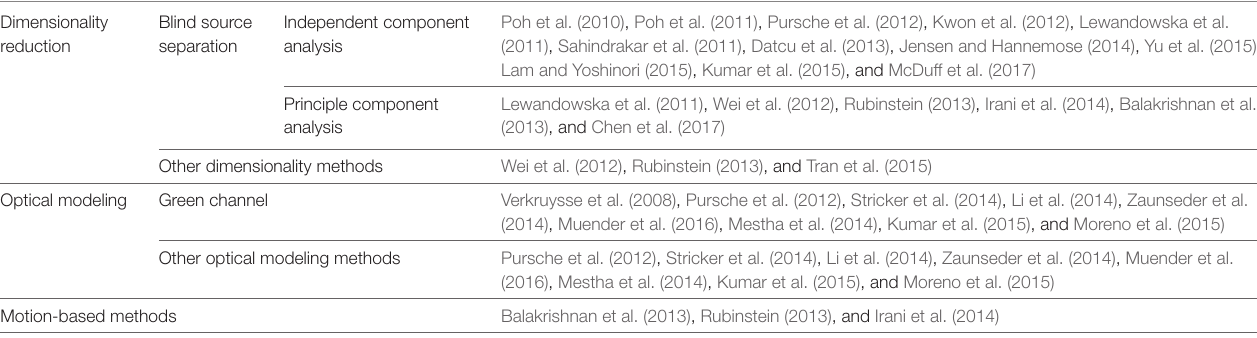
table 1 | Classification of state-of-the-art methods. Dimensionality